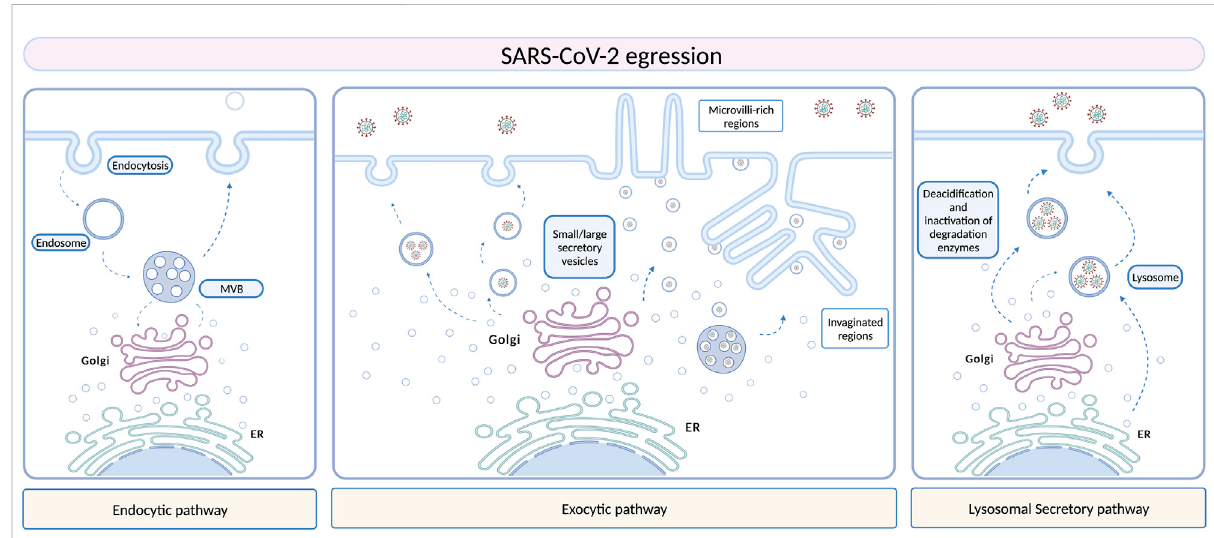
FIGURE 1 Different hypotheses have been stated and are still under investigation to de fi ne SARS-CoV-2 egression routes. Several morphological studies support a role of EVs in SARS-CoV-2 egression, especially the exocytic pathway, which involves membrane remodeling and formation of peculiar structures, as microvilli-rich or invaginated regions. Another hypothesis is the lysosomal pathway, but the fusion of these organelles with the plasma membrane is still unknown. Created with